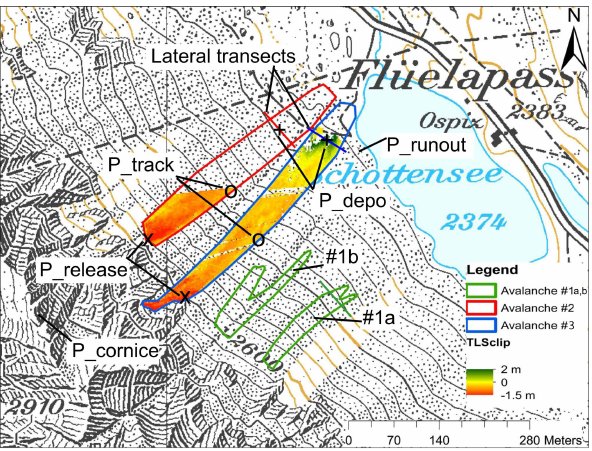
Figure 2. Flüelapass field site close to Davos (Switzerland). Out- lines of avalanche #1a and #1b (green), #2 (red) and #3 (blue). The colour bar shows differences between terrestrial laser scans before and after the individual avalanches. P release and P track indicate loca- tions of snow profile in the release and along the path, respectively. Red and blue lines indicate positions of lateral investigations and deposition snow profile P depo